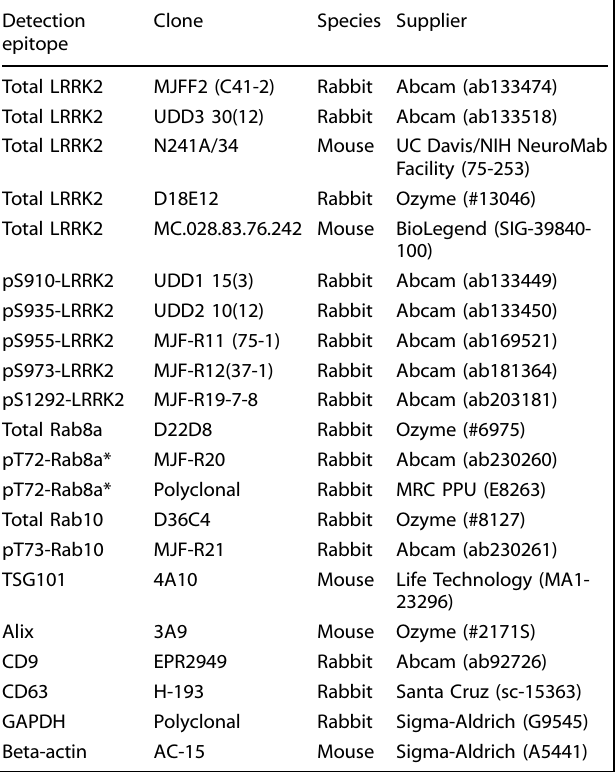
Table 4. List of antibodies used in the study, including clone information, species in which the antibody was raised and